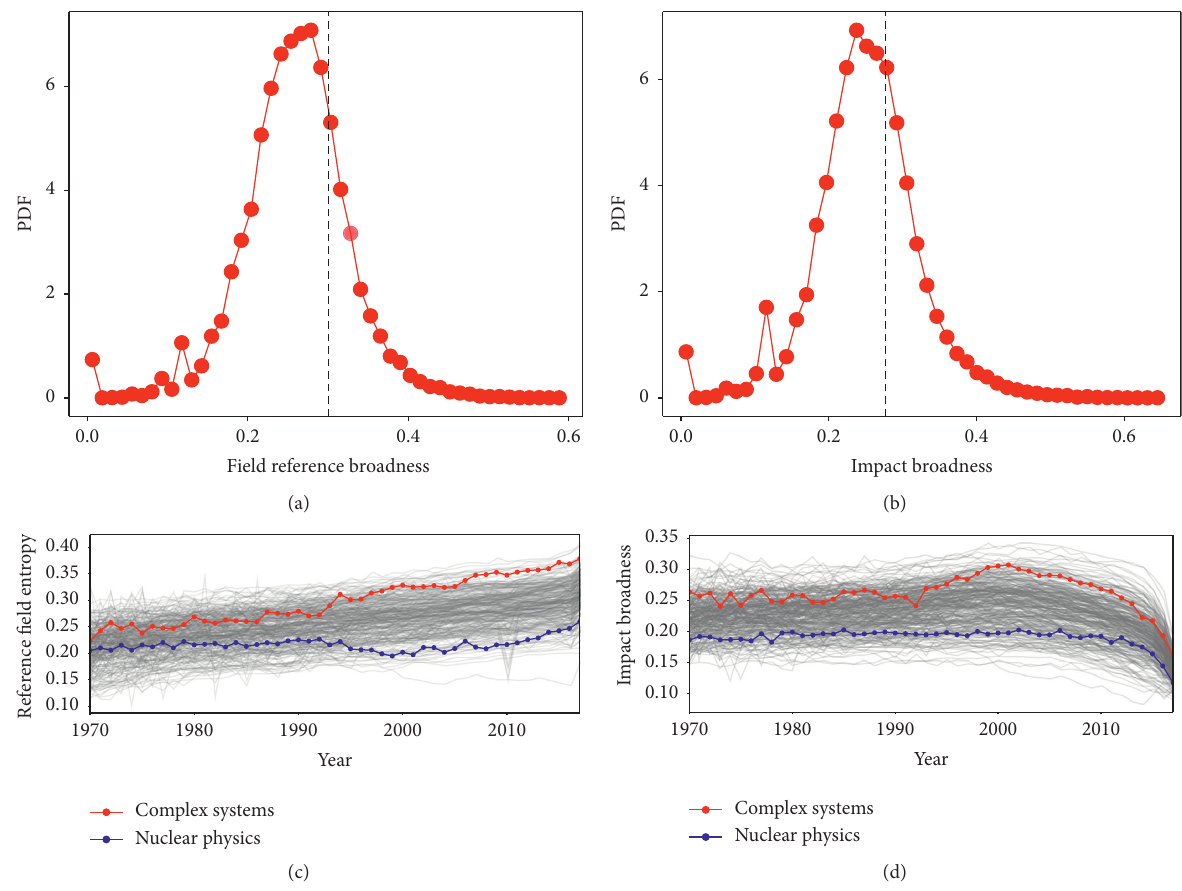
Figure 4: Field referencing and citation broadness. The distribution of field reference (a) and impact broadness (b) at 1995, with the dashed line representing complex system research. (c) Field’s reference broadness as a function of time, with red and blue lines showing the field of complex systems and nuclear physics, respectively. (d) The same as (c) but for impact broadness.